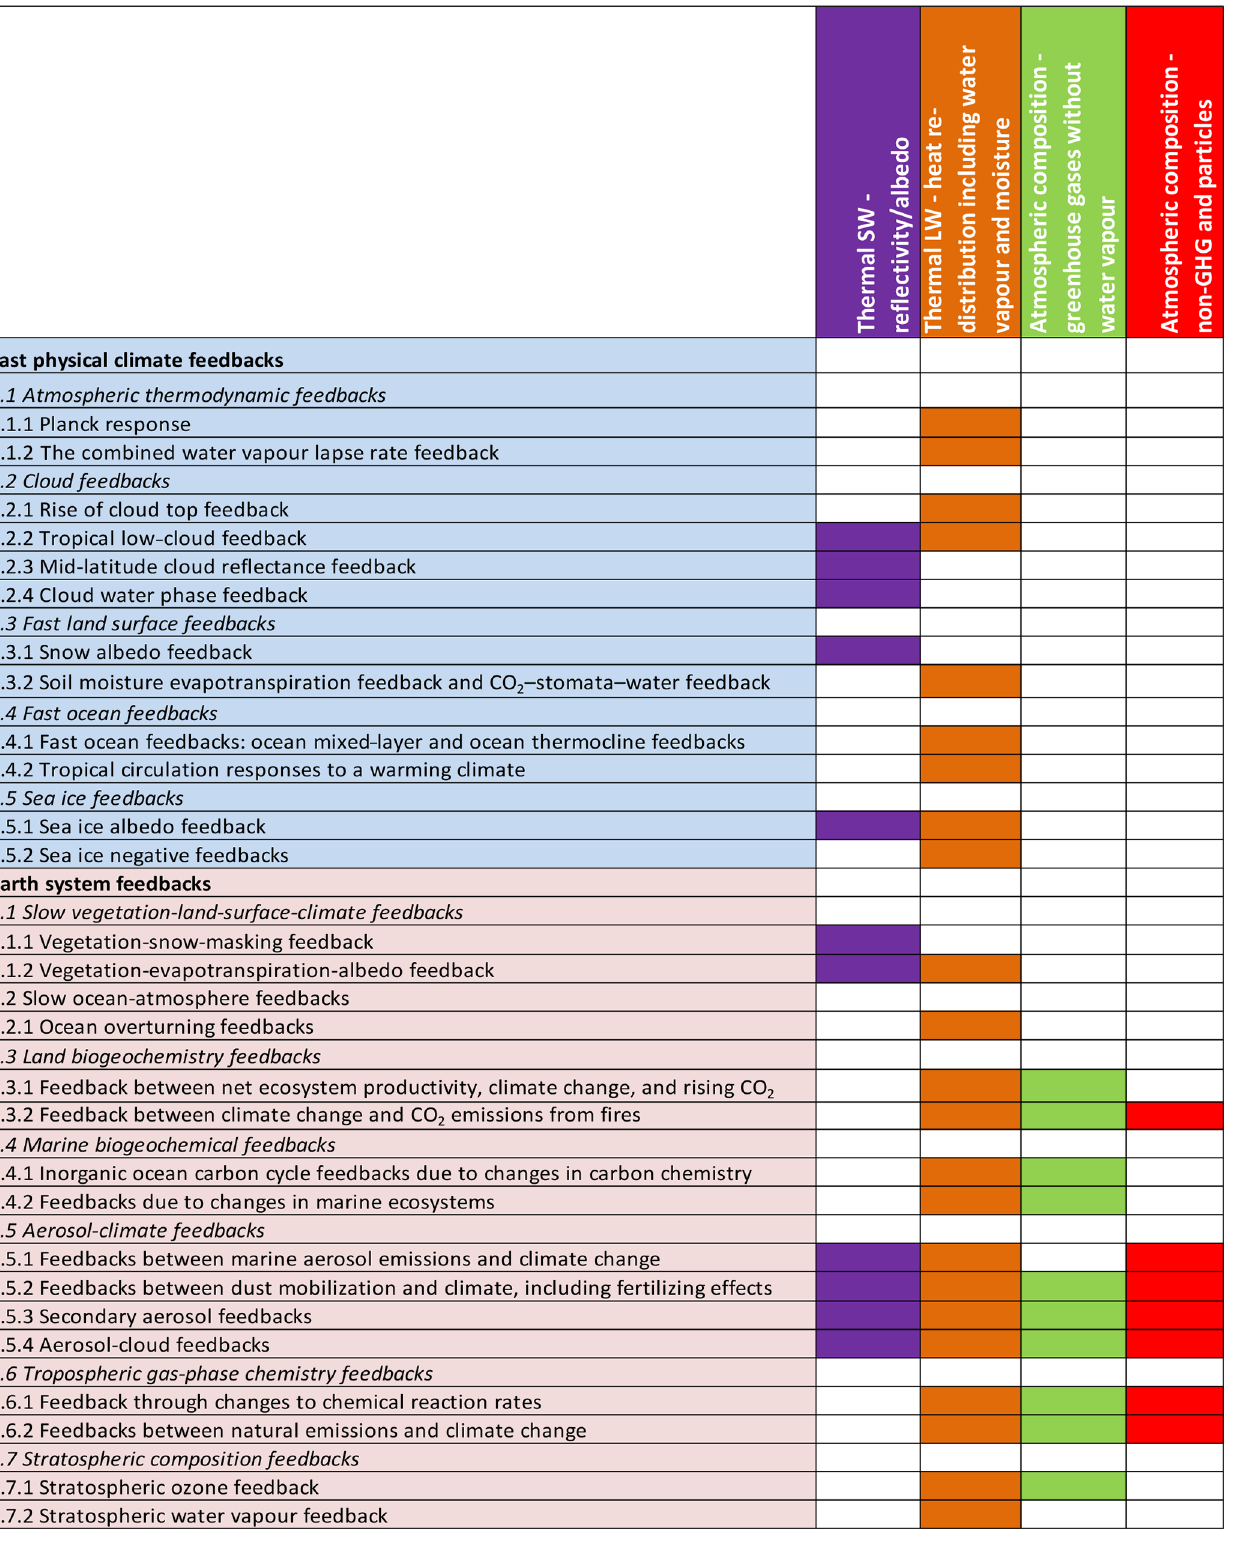
Table 1. Classification of specific feedbacks (left vertical column) with respect to general “archetypes” of feedbacks. Feedbacks can